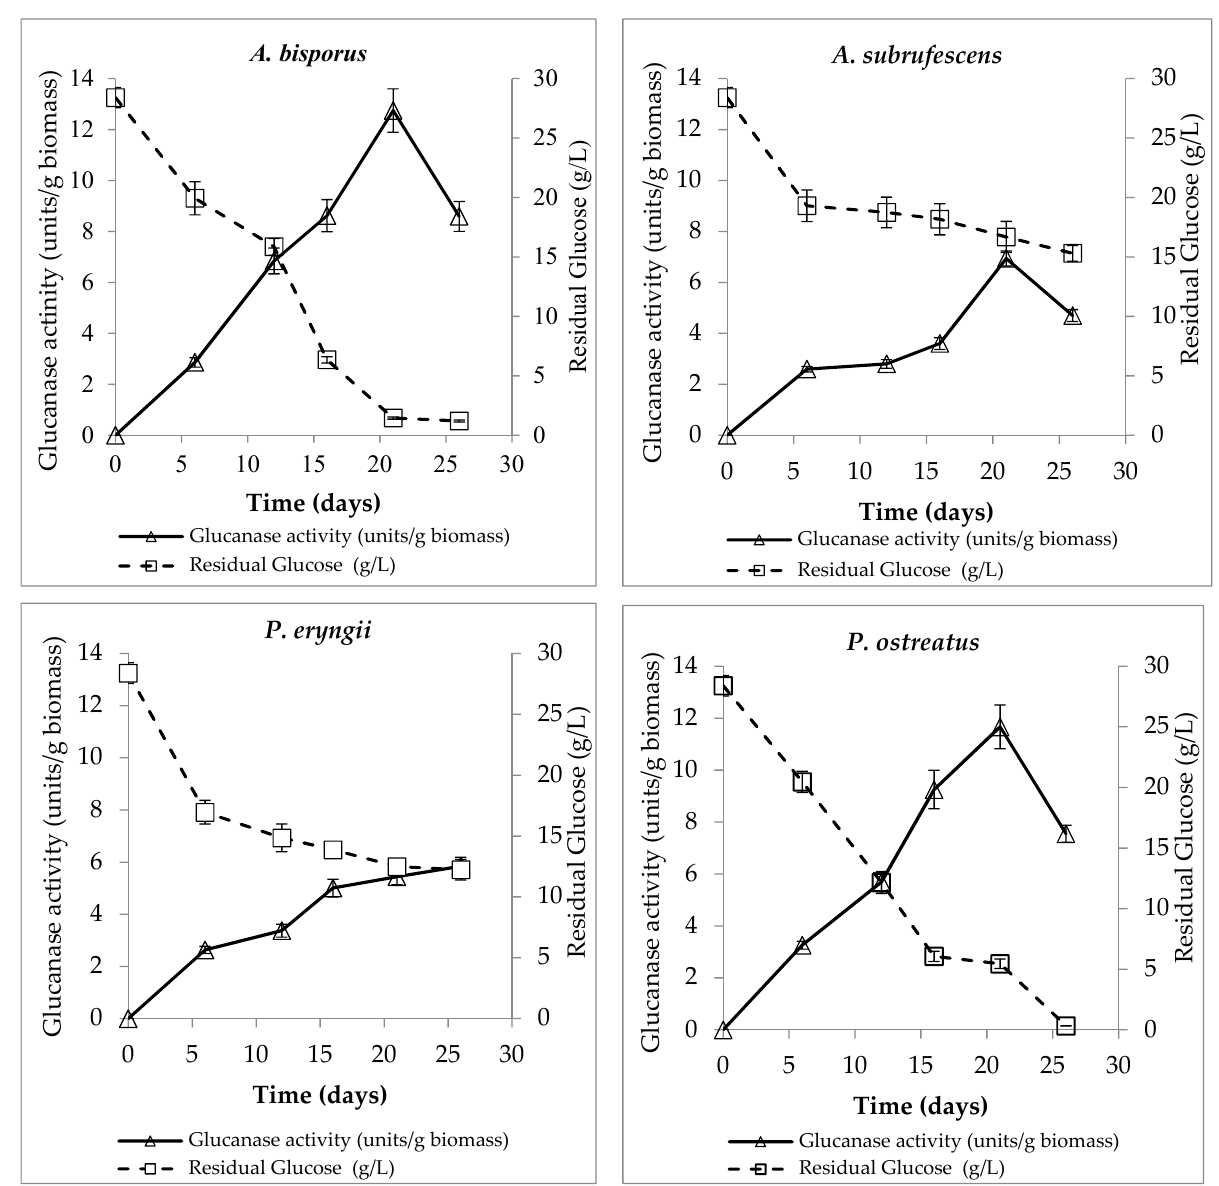
Figure 6. Residual glucose and glucanase activity of A. bisporus , A. subrufescens , P. eryngii and P. ostreatus during their cultivation in agitated (120 ± 5 rpm) liquid cultures of C/N molar ratio 20, at 26 ± 1 °C.